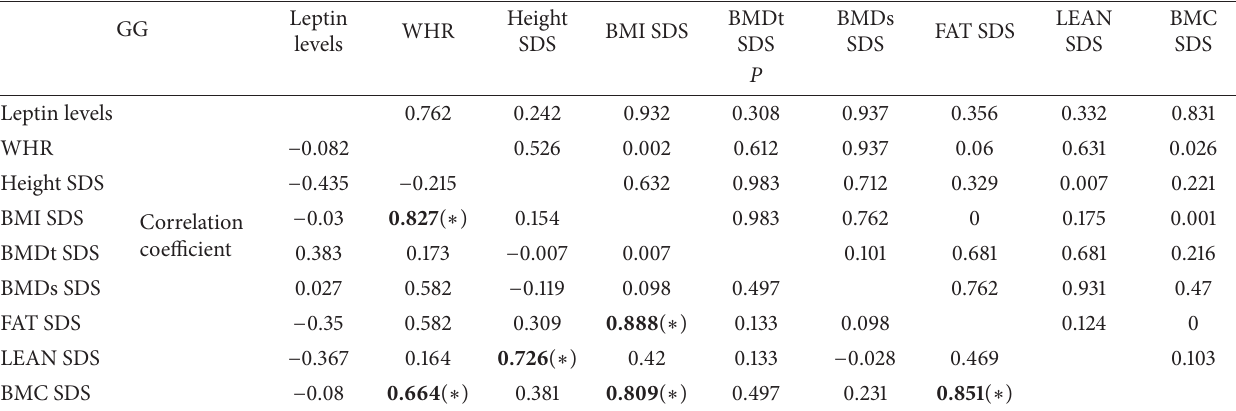
Table 8: Correlation between anthropometric and densitometric parameters in the group with LEPR gene genotype GG. GG